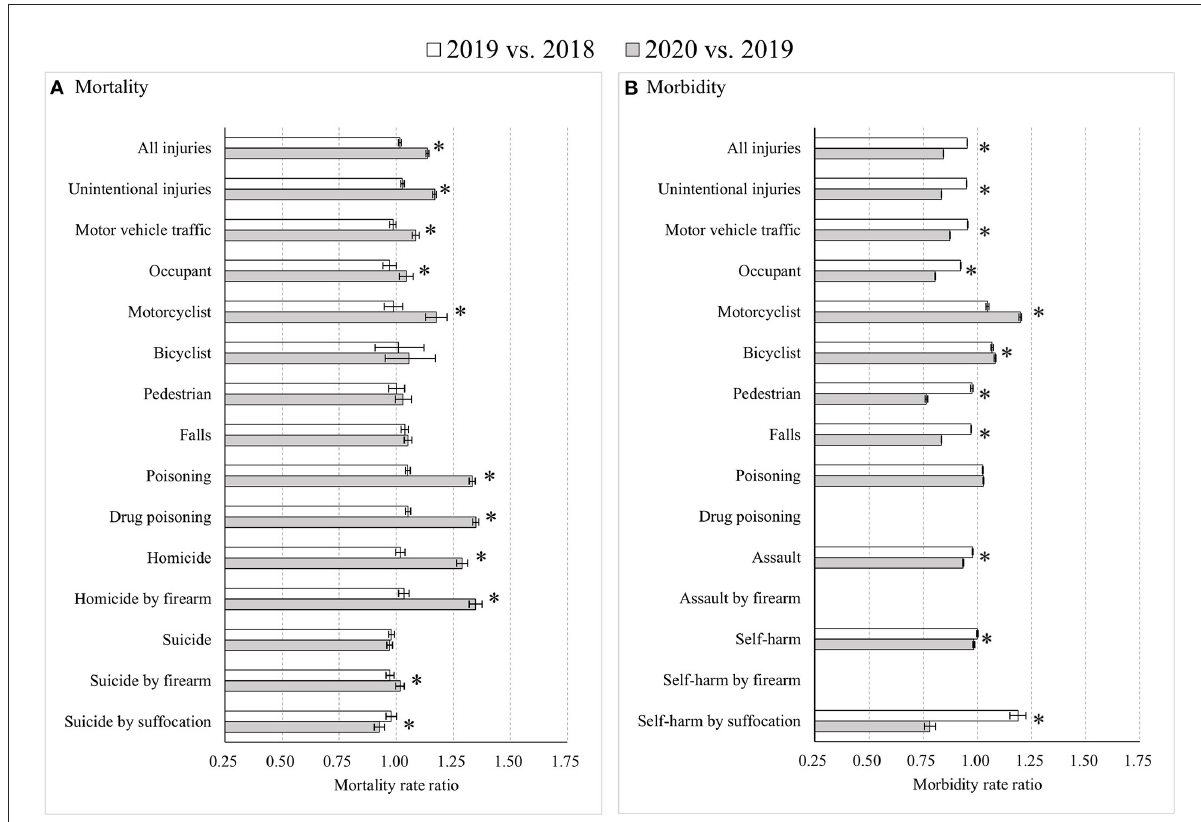
FIGURE1 Age-standardized injury mortality/morbidity rate ratios among Americans for all age groups, 2019 vs. 2018 and 2020 vs. 2019. (A) Mortality; (B) Morbidity. Results were omitted for categories having unstable injury morbidity rates (due to the computation based on cases < 20, the national estimates < 1,200, the coefficient of variation > 30%, or the tool not involving details regarding mechanism of relevant injury). “*” indicates that the differences of MtRRs or MbRRs between 2020 vs. 2019 and 2019 vs. 2018 were statistically significant.